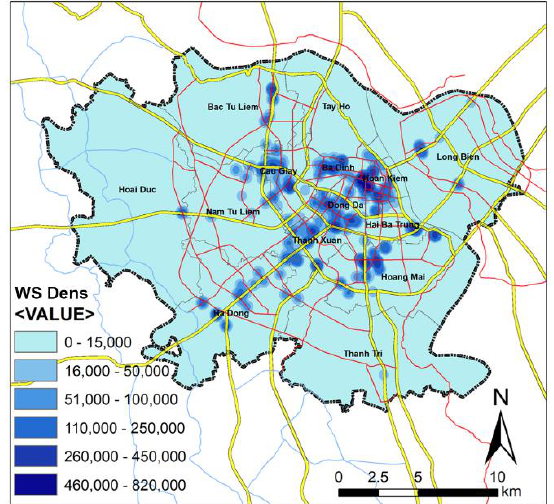
Figure 6. Waterlogging spot density (WS-Dens) map.